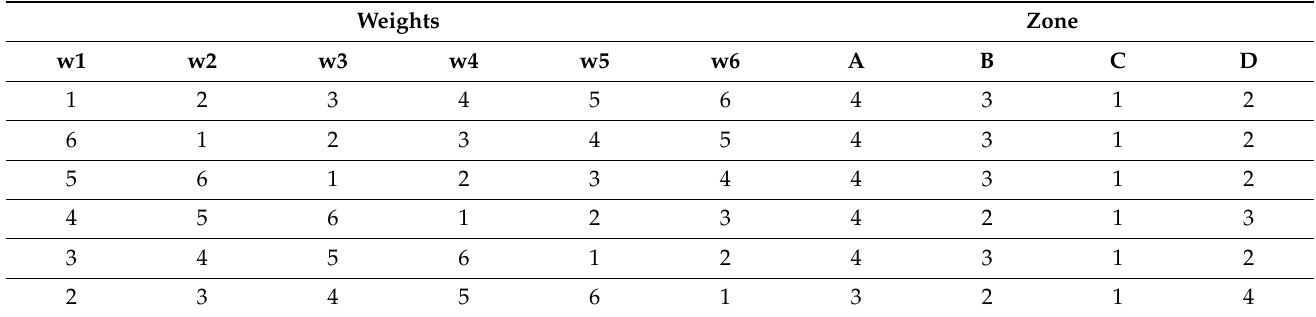
Table 6. Zones ordered according to the weight attributions.